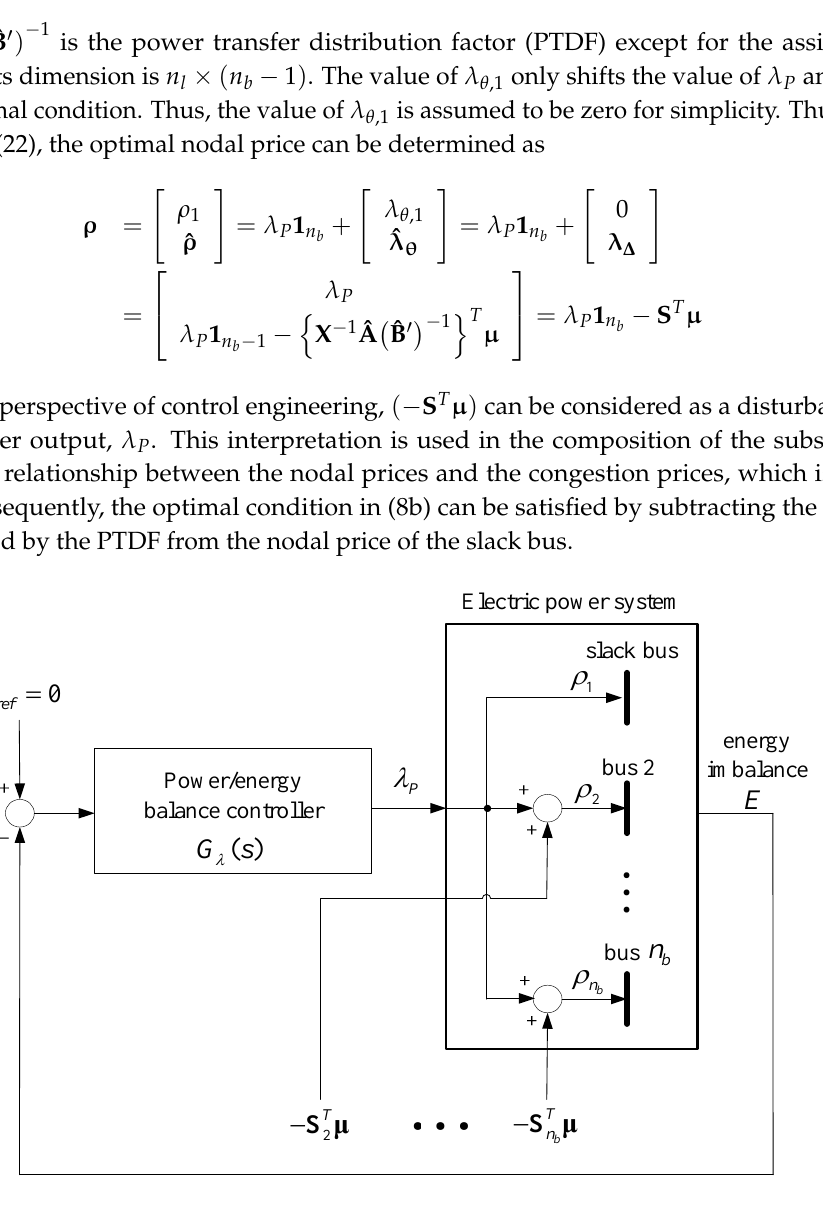
Figure 1. Substructure for the relationship between the nodal prices and congestion prices.